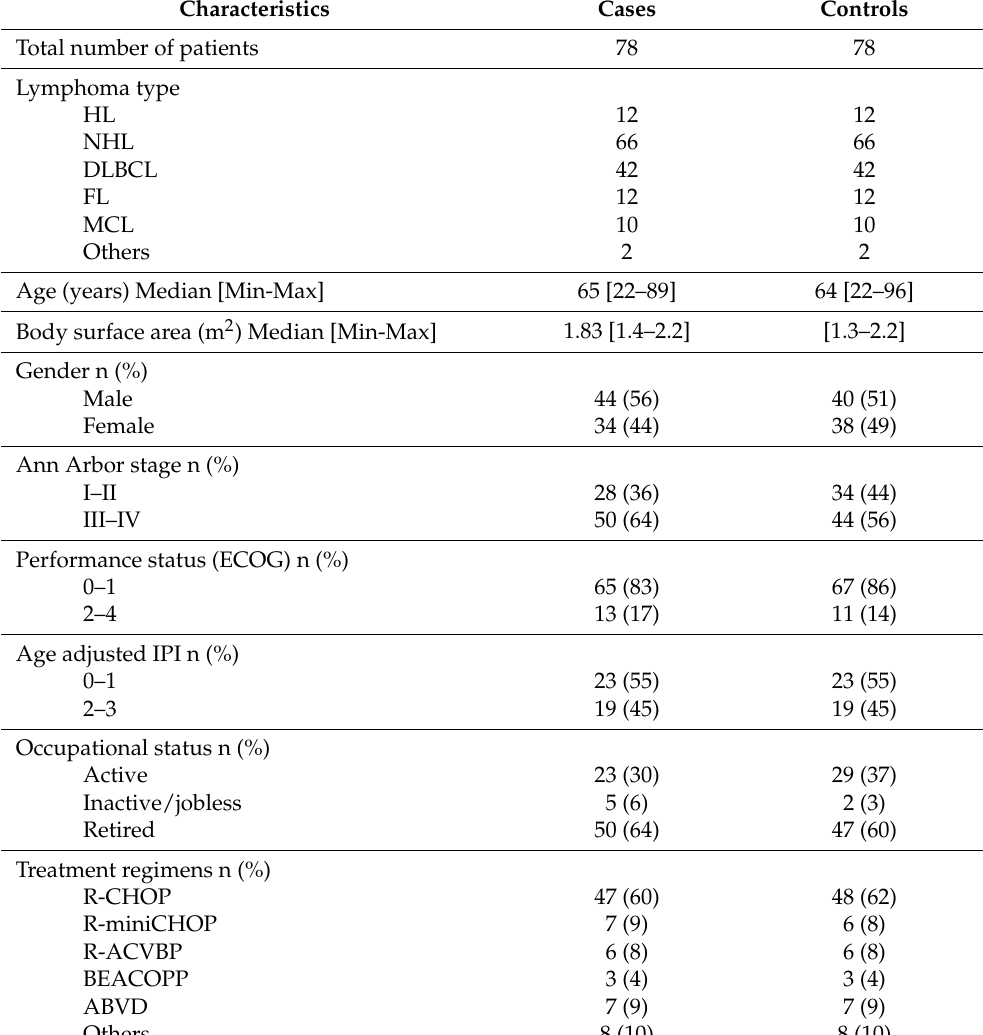
Table 2. Characteristics of cases and controls